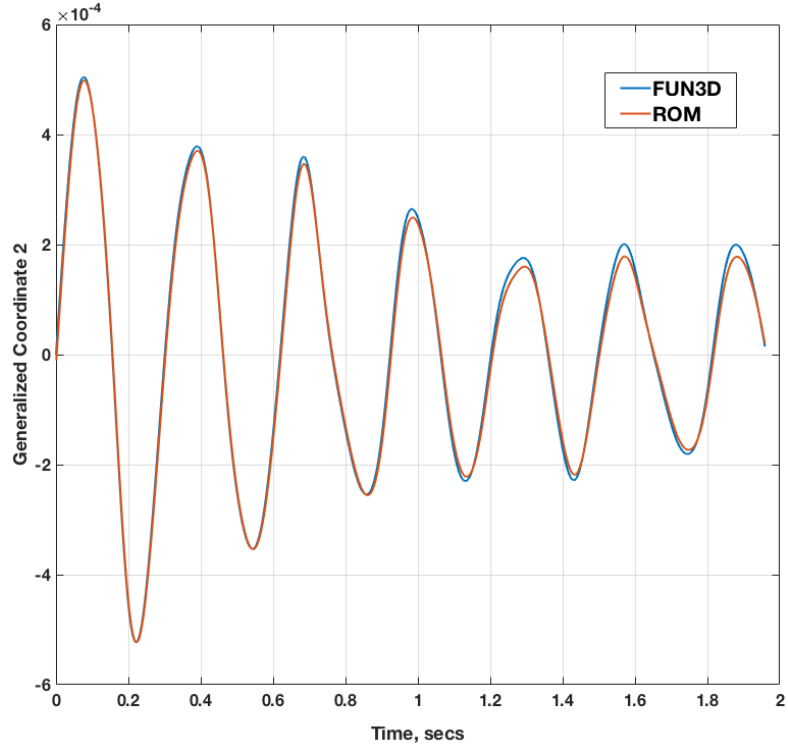
Figure 8. Comparison of full FUN3D aeroelastic response and ROM aeroelastic response for the second mode of the N+2 configuration at M = 1.7 and a dynamic pressure of 2.149